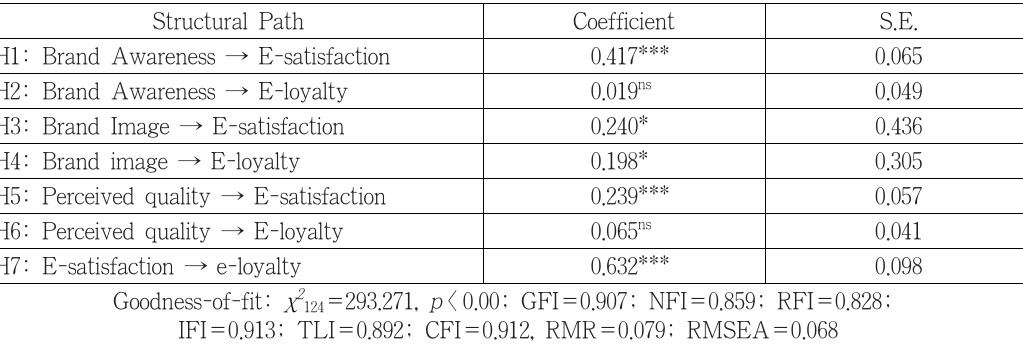
<Table 3> Structural Model